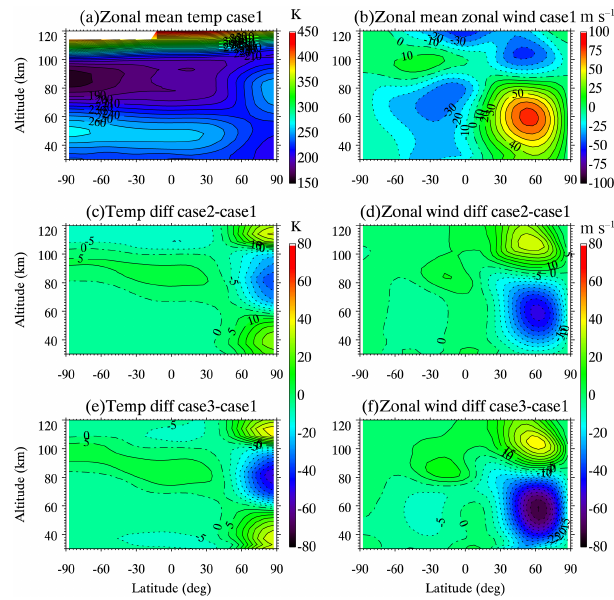
Figure 4. The zonal mean (a) temperature and (b) zonal wind in case 1 on model day 28. The temperature and zonal wind differences between (c, d) case 2 and case 1 and (e, f) case 3 and case 1 are also shown. The temperature contour intervals are 10K in (a) and 5K in (c) and (e) . The zonal wind contour intervals are 10ms − 1 in (b) and 5ms − 1 in (d) and (f) .